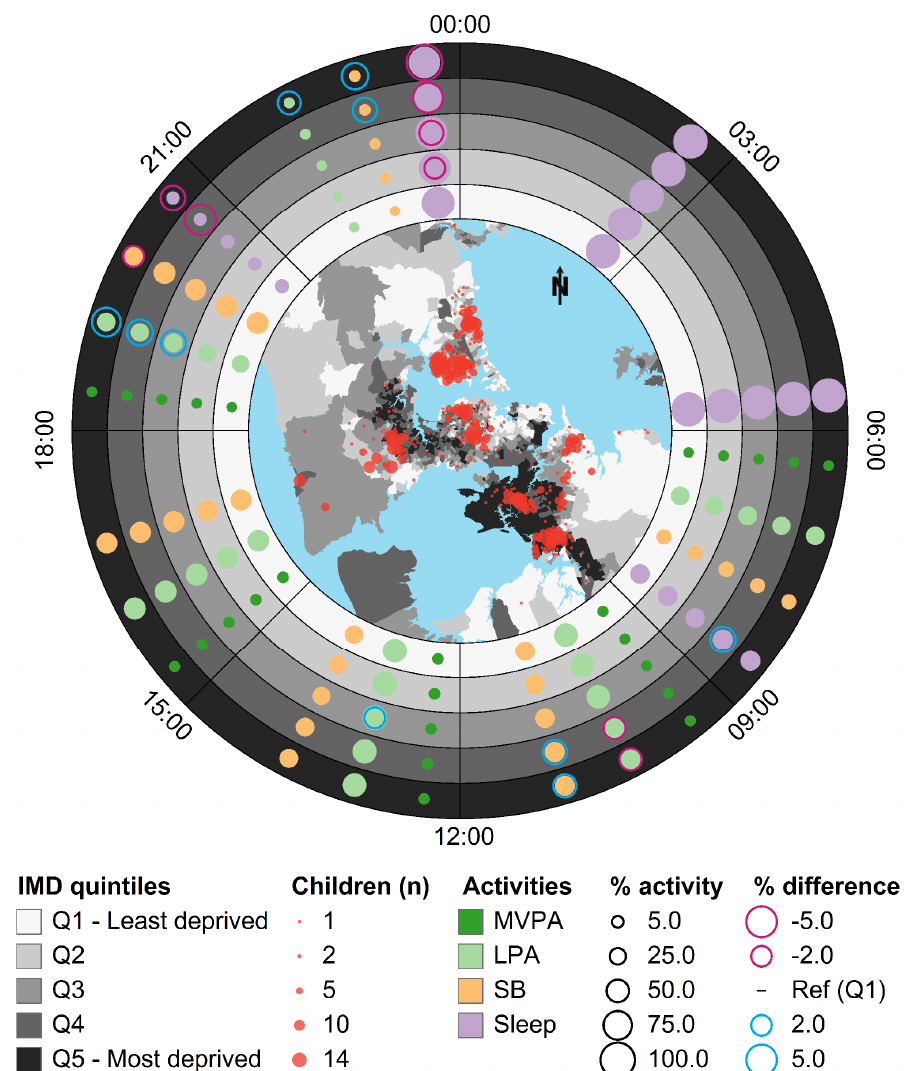
Figure 2. Ringmap showing overall spatial and temporal activity patterns over 24 h on weekdays for all children ( N = 882) and their association with deprivation. The geographic units in the inset map are Data Zones and proportional semi-transparent dots in red represent aggregated number of children who lived in each Data Zone. Each ring in the ringmap represents a quintile of IMD deprivation, which is divided into eight 3-h time blocks ordered clockwise from midnight at the top. White to black shades represent IMD quintiles from 1 (the least deprived) to 5 (the most deprived) in both the inset geographic map and the 5 rings. In each time block, the average percentage of time spent on each activity is displayed using proportional coloured dots. Dark green represents MVPA, light green represents LPA, orange represents SB, and purple represents sleep. To facilitate comparison between the same activity in the same time block across the five IMD quintiles, proportional circular outlines representing negative and positive differences in average percentage of time spent on each activity compared to the least deprived quintile (% difference = 0%) are overlaid. Percentages of less than 1% and differences in percentages between − 2% and 2% are suppressed.